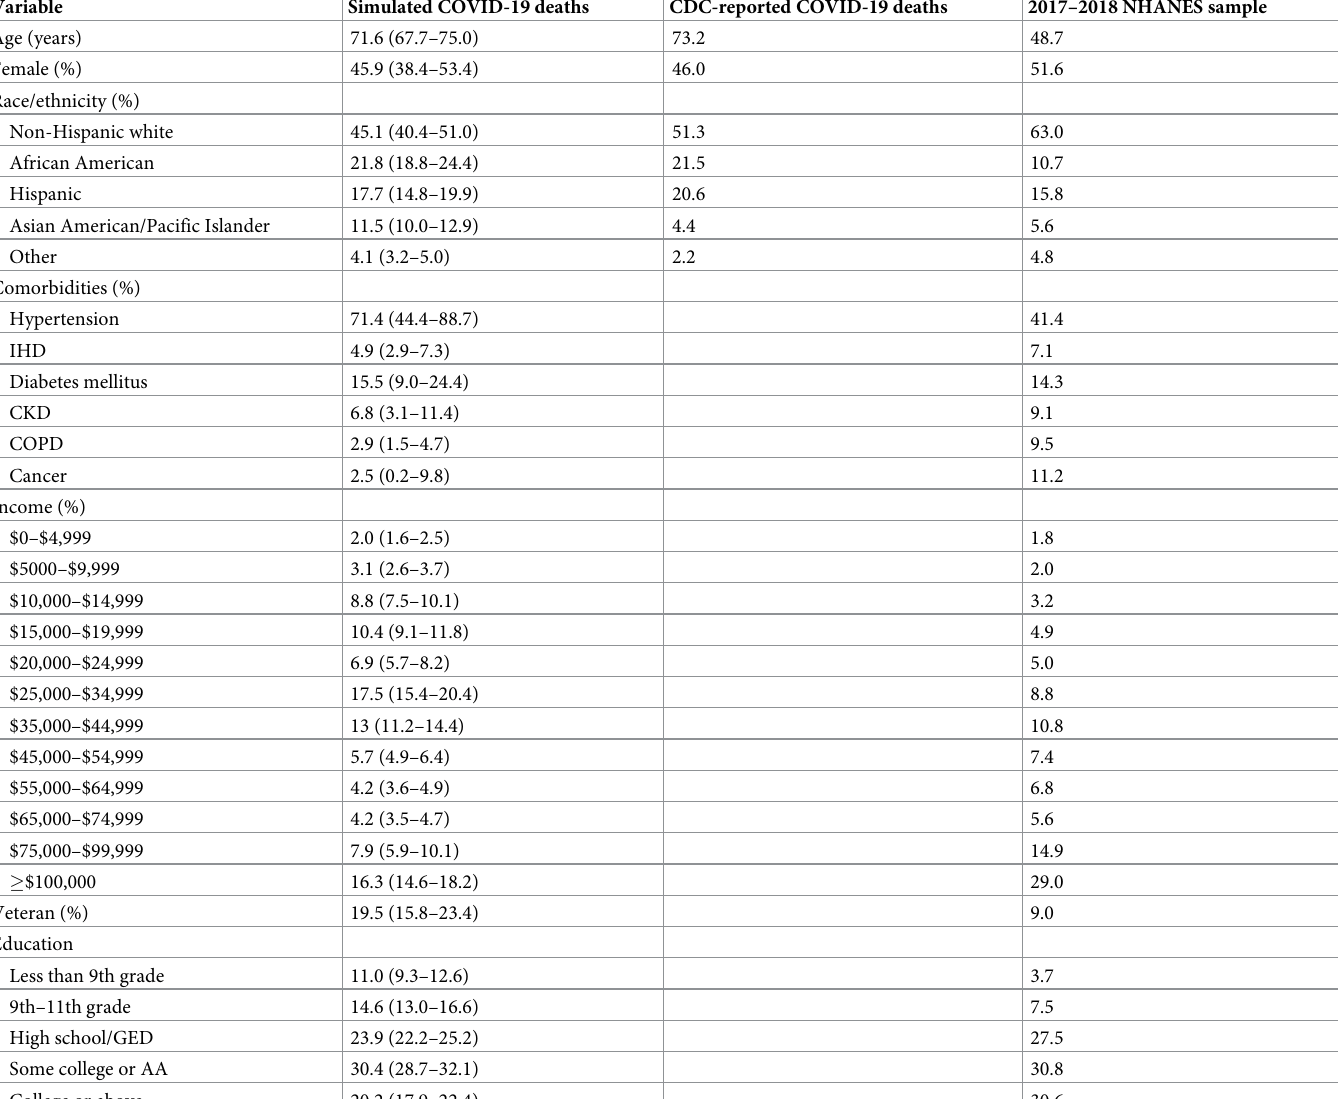
Table 1. Characteristics of simulated COVID-19 deaths and the weighted NHANES